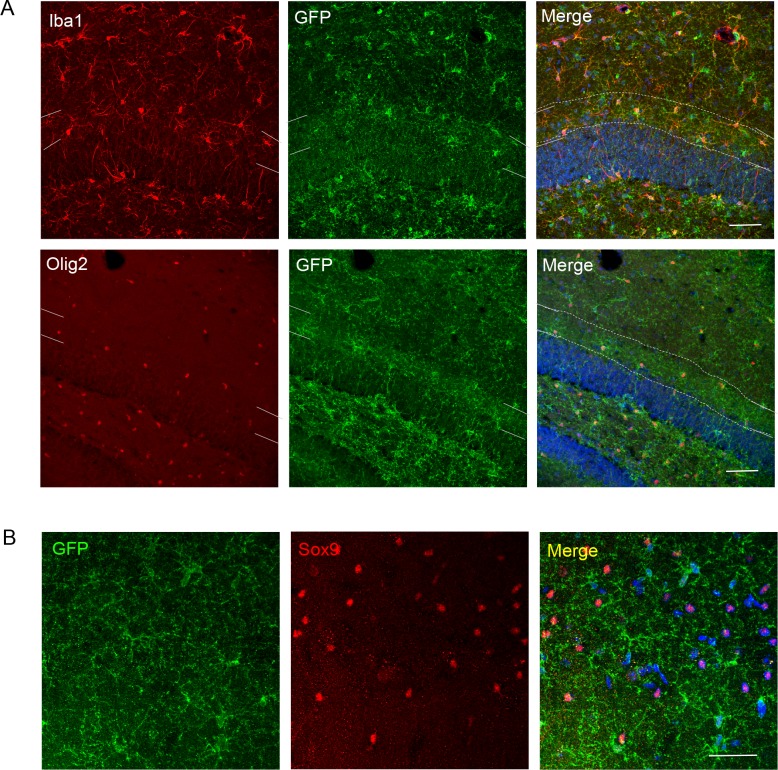
Further analysis of P2X7-EGFP expressing cells in the dentate gyrus and CA1 region.(A) EGFP co-labeling (10262, Thermo Fischer Scientific, ab6556, Abcam) with Iba1 and Olig2 in the dentate gyrus. Iba1-positive microglia and Olig2-positive oligodendrocytes appear to align at the border between granular and molecular layers resulting in a region of more intense staining (indicated by white dotted lines and corresponding marks in the (merge) and at the side of the single channel pictures, respectively). Scale bar: 50 μm. DAPI staining in blue. (B) Co-staining of EGFP (A10262, Thermo Fischer Scientific) with the alternative astrocyte marker Sox 9 in the CA1 region. Scale bar: 50 μm. DAPI staining in blue (n = at least three animals in all experiments).